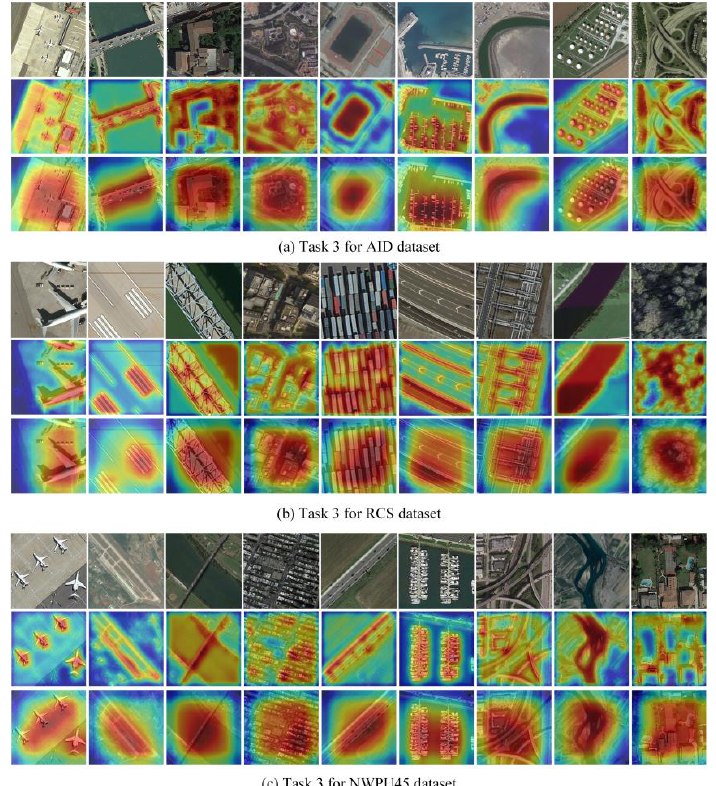
Figure 9. The confusion matrix of third step task on NWPU dataset.